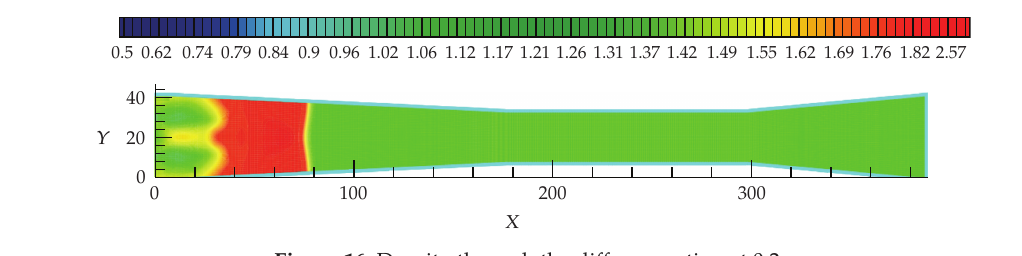
Figure 16: Density through the di ff user section at 0.2s